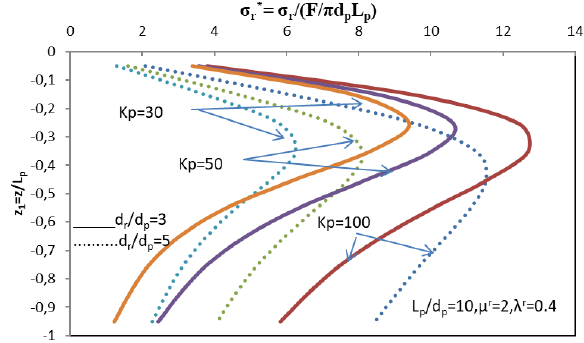
, with normalized depth, pd /d =10, d /d =3, λ r p p r p